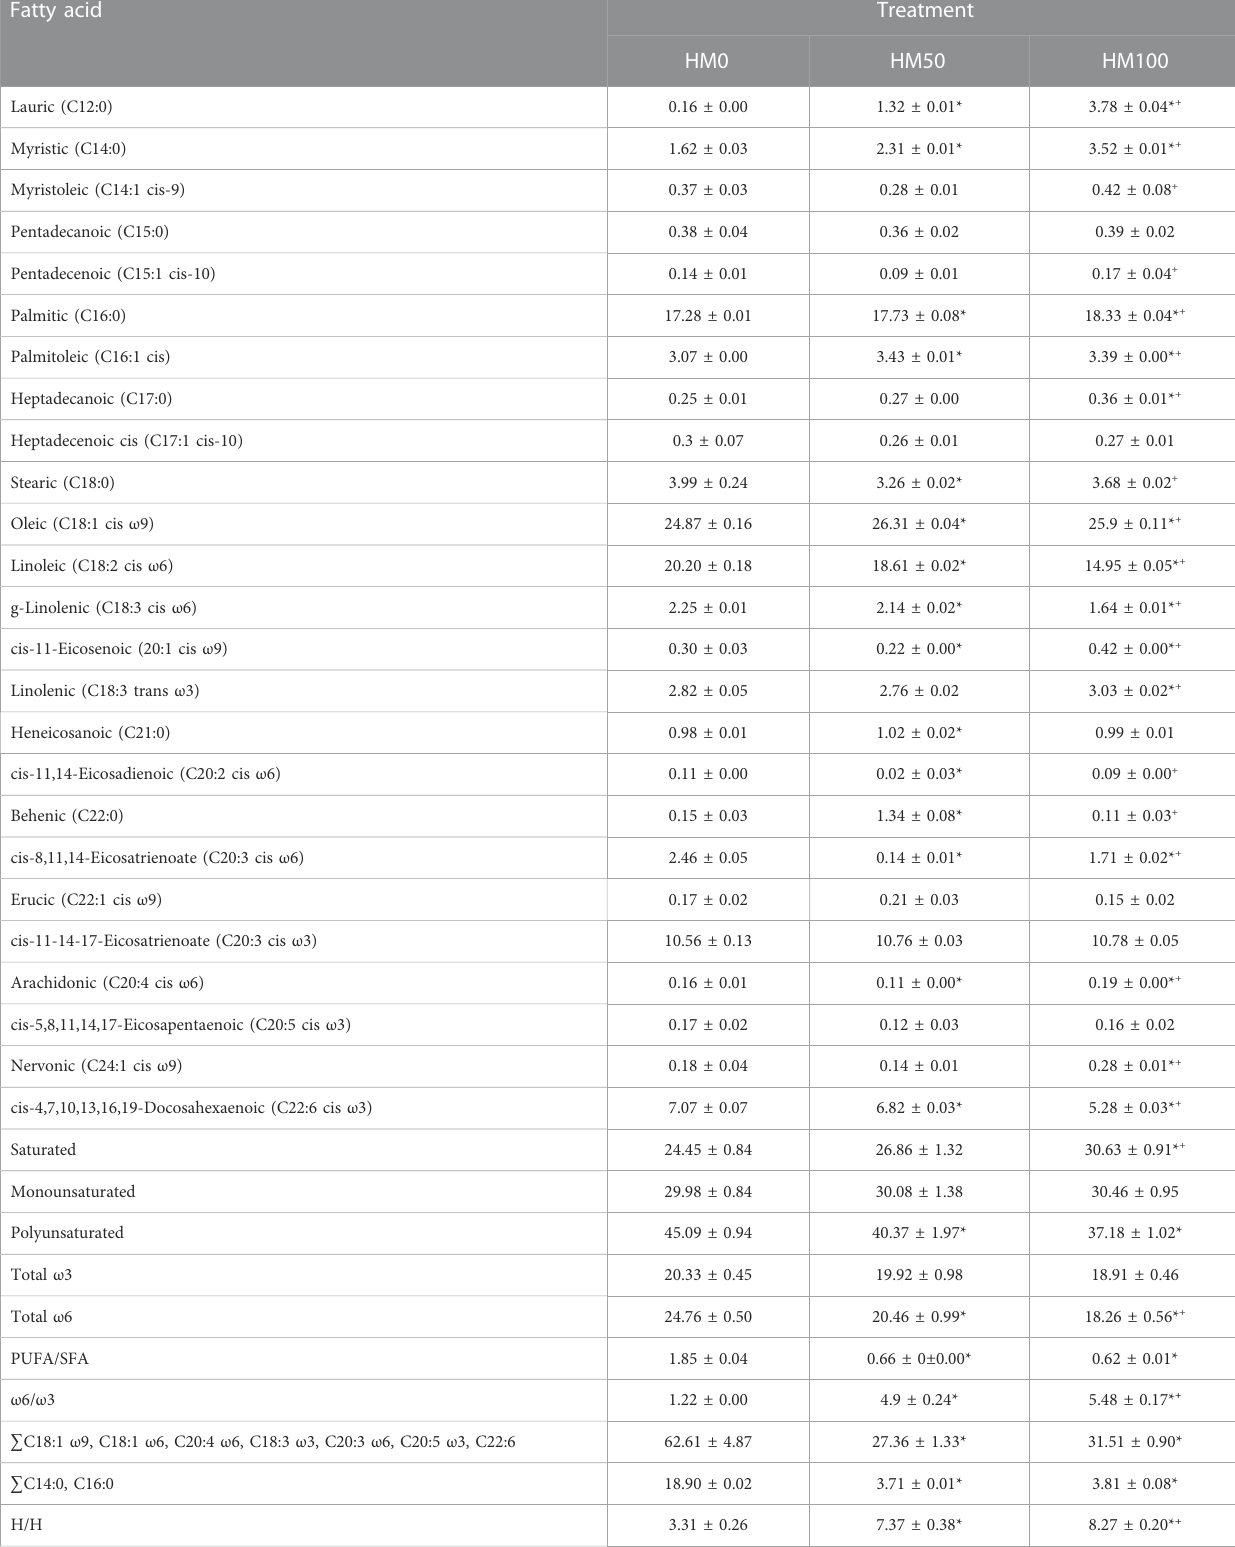
Asterisk (*) depicts statistically signi fi cant differences ( p < 0.05) between HM, treatments and HM0, while cross (+) depicts statistically signi fi cant differences ( p < 0.05) between HM50 and HM100 treatments. Mean value ± S.D. ( n =